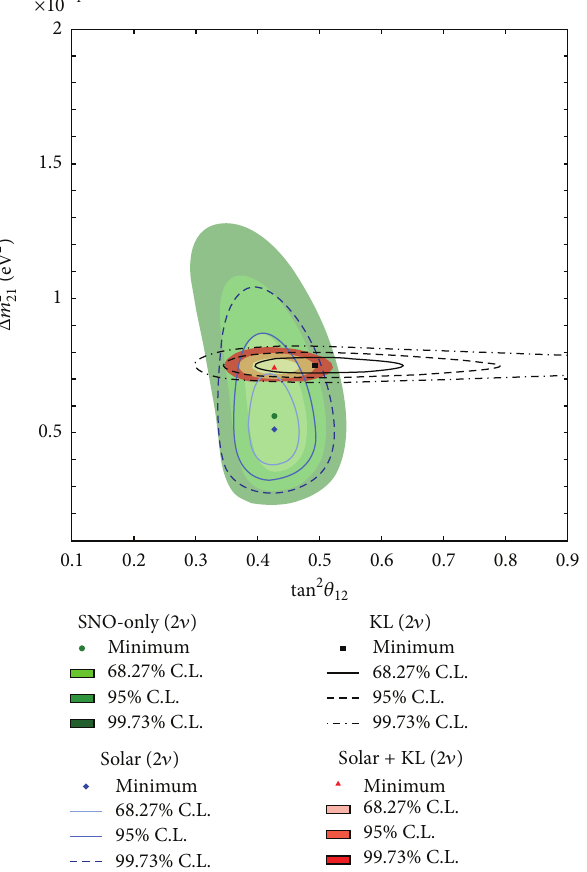
Figure 13: Two-flavor neutrino oscillation analysis contour using both solar neutrino and KamLAND results (taken from